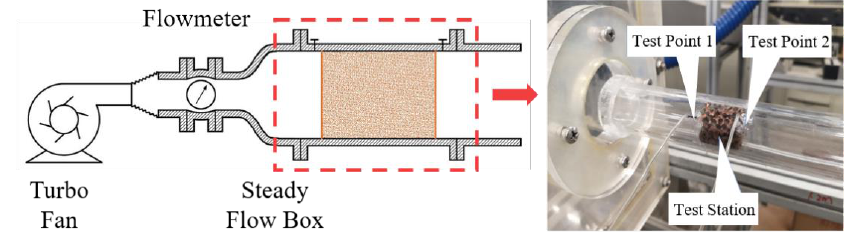
Figure 10. Schematic of the pressure drop measurement device.